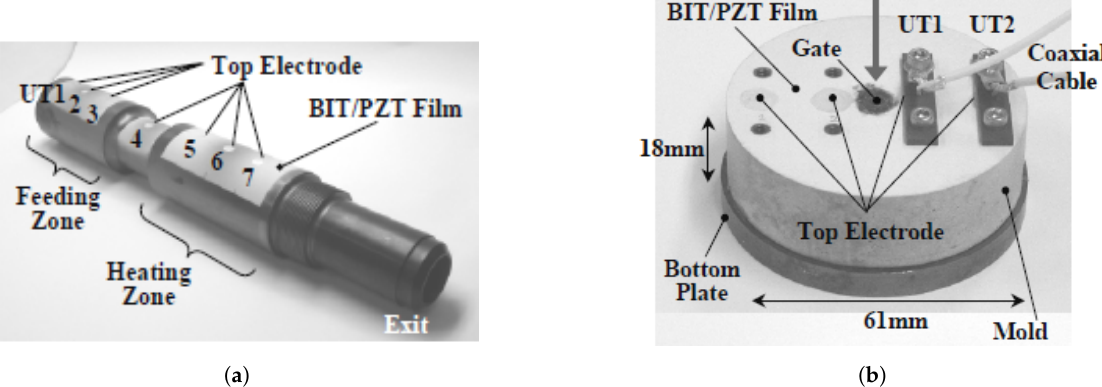
Figure 6. Fabricated sol-gel ultrasound sensors in the micromoulding process ( a ) on the barrel and ( b ) at the mould insert